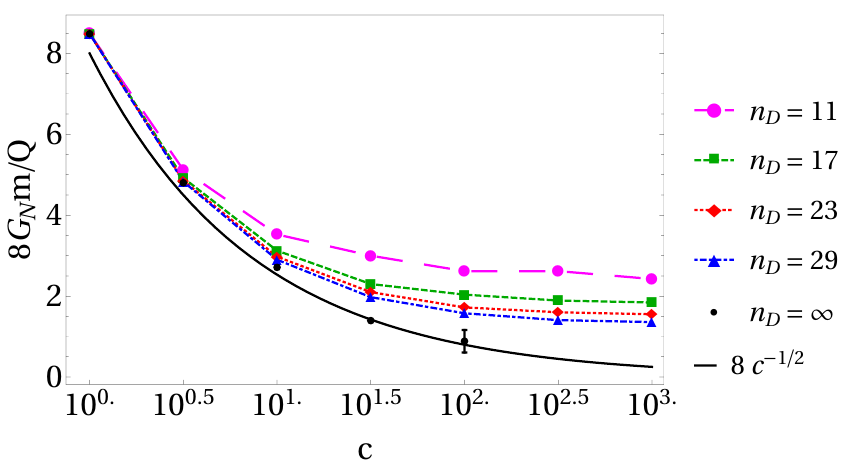
Figure 2 . Bound of mass-to-charge ratio as a function of c ; a trend line / c (cid:0) 1 = 2 is shown for comparison. The extrapolation (\ n D = 1 " points) and error bars are computed by performing a (cid:12)t as a function of n D and extrapolating to n D ! 1 as described in the